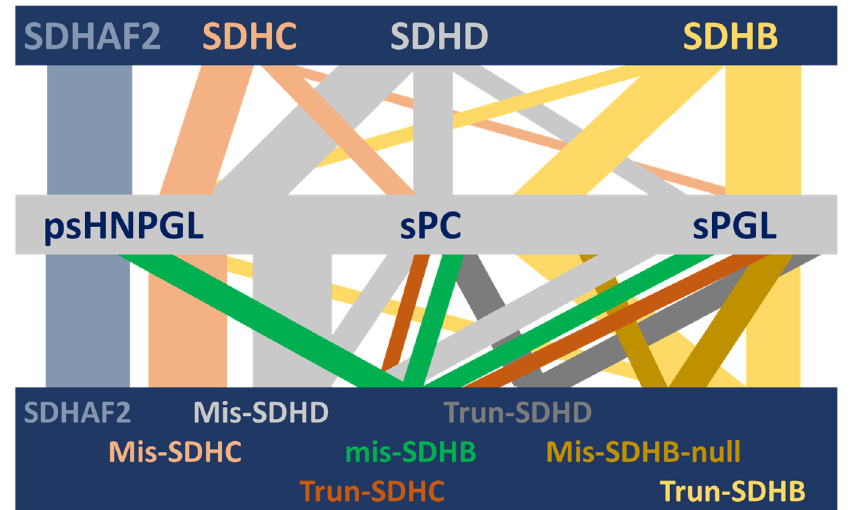
Figure 1. Visual depiction of the complex HNPGL/PPGL clinical spectrum associated with succinate dehydrogenase and its variants [8,9]. Although succinate dehydrogenase is a single protein complex, genetic variants in SDH genes and one assembly factor gene are associated with a range of different but often overlapping HNPGL/PPGL phenotypes. This diversity is unexplained to date. In this illustration, the horizontal bars depict (from top to bottom) the relevant SDH genes, the associated clinical phenotypes and the relevant gene-variant types (SDHAF2 is unannotated in the lower bar because all variant types result in exclusively HNPGL). Vertical bars depict the diversity of phenotypic associations, with the width approximating the strength of a gene–clinical relationship. SDHAF2, SDHC and SDHD show psHNPGL-biased phenotypes, while SDHB is biased towards sympathetic sPC and sPGL tumors. SDHAF2 = succinate dehydrogenase assembly factor 2; SDHC, SDHD, SDHB = succinate dehydrogenase subunit C, D and B, respectively; psHNPGL = parasympathetic head and neck paraganglioma; sPC = sympathetic pheochromocytoma; sPGL = sympathetic paraganglioma; Mis = missense; Trun = truncating; ‘null’ indicates missense variants that act as null alleles.